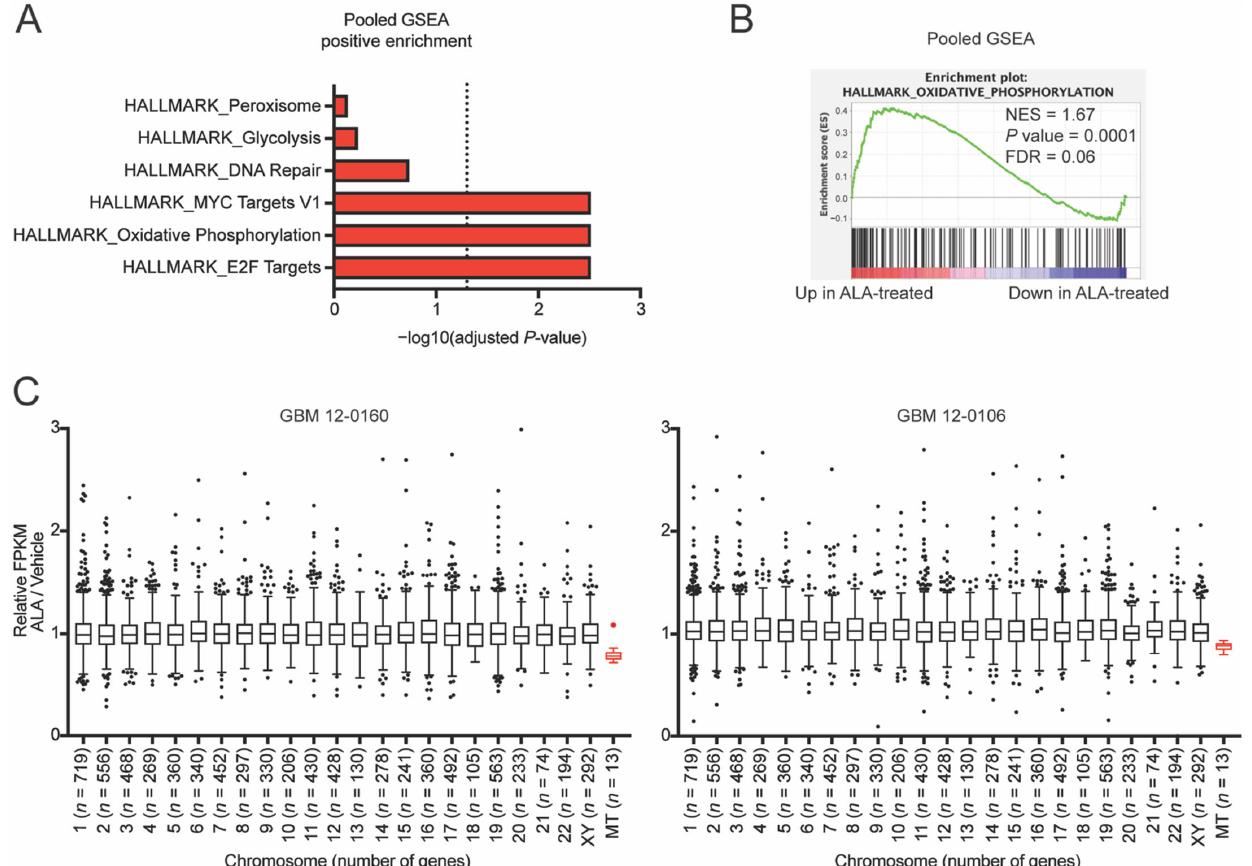
Figure 2. Inhibition of de novo purine synthesis using L ‐ Alanosine (ALA) alters glioblastoma (GBM) cells’ oxidative phosphorylation genes and mtDNA gene expression. ( A ) Gene set enrichment analysis (GSEA) of pooled mRNA ‐ seq of GBM 12 ‐ 0160 and GBM 12 ‐ 0106 cells pretreated for 2 weeks with ALA 0.25 μ M highlights positively enriched Hallmark pathways; dashed line represents p = 0.05. ( B ) GSEA enrichment plots for oxidative phosphorylation show a positive enrichment with ALA treatment. ( C ) Individually analyzed mRNA ‐ seq shows that ALA decreases expression of mitochondrial DNA ‐ encoded (MT) genes (shown in red). Genes with FPKM of at least 10 were included in analysis. Outlier genes ( n = 3 genes) excluded from plot for data visualization purposes. p < 0.0001 for MT vs. each other chromosome. Data shown are mean +/ − SEM. Data analyzed using Mann ‐ Whitney test ( C ).